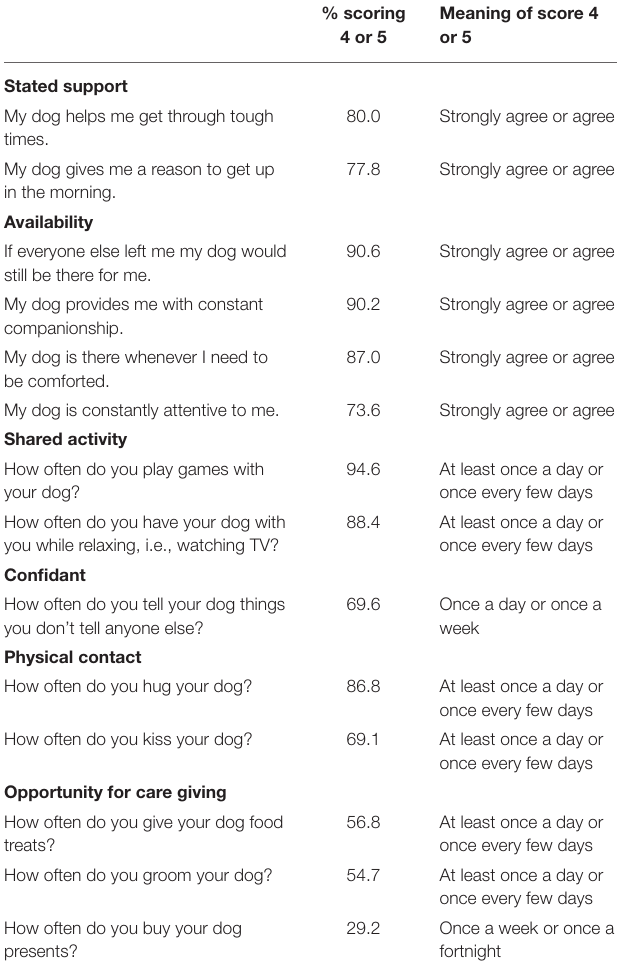
TABLE 4 | Key items from MDORS that relate to social support, with the percentage of respondents who gave the positive responses for each item (representative sample